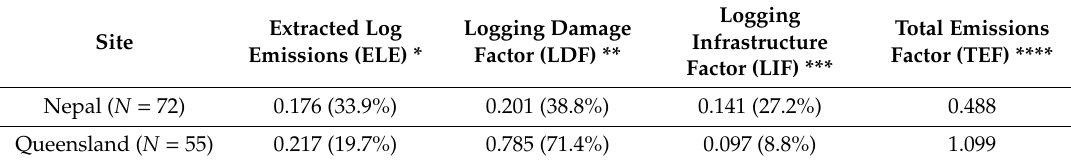
Table 8. Total emissions factor in Mg C per m 3 of harvested